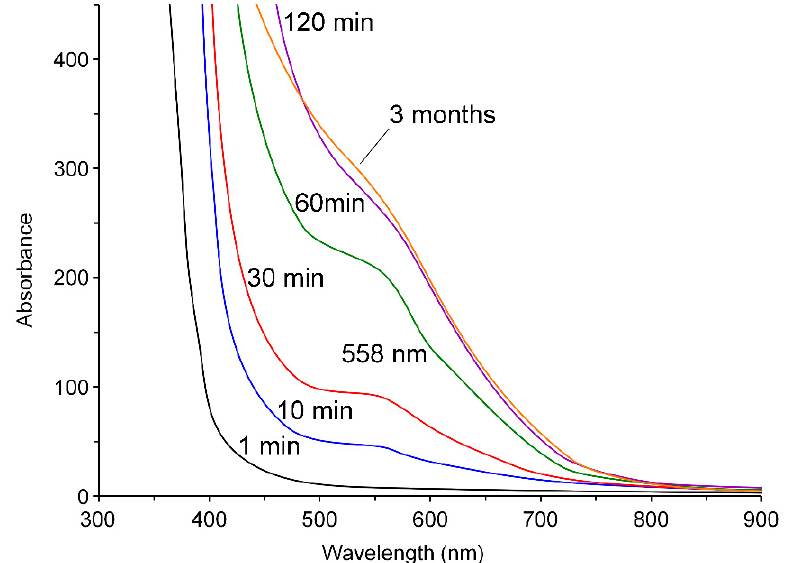
Figure 2. UV–visible spectra of NC(Cu-PVI).